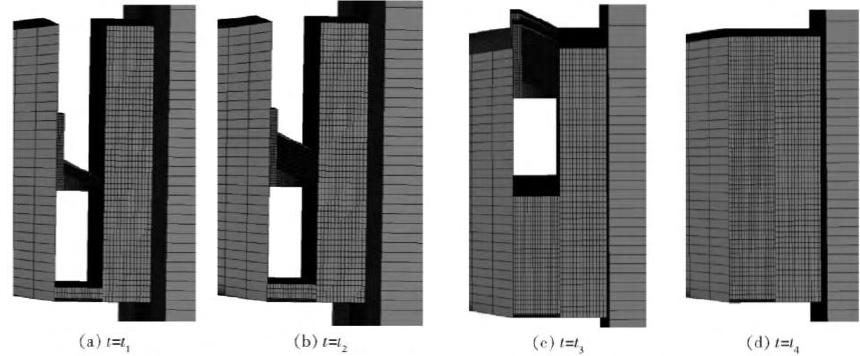
Figure 25. Grid motion of outlet channel gate with additional flap gate [29].